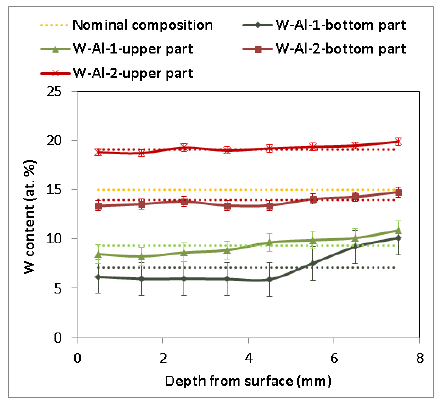
Figure 3. Concentration profile of cuts of W – Al samples after VIM (EDS, dotted lines indicate average value).